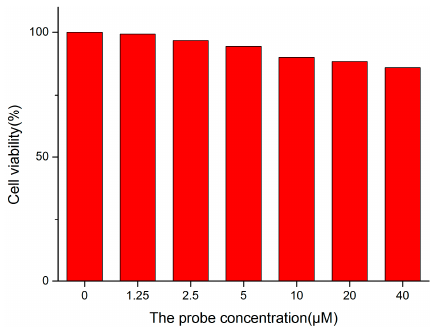
Figure 5. HeLa cell viability values (%) estimated by MTT assay at different concentrations of probe 1 for 24 h.